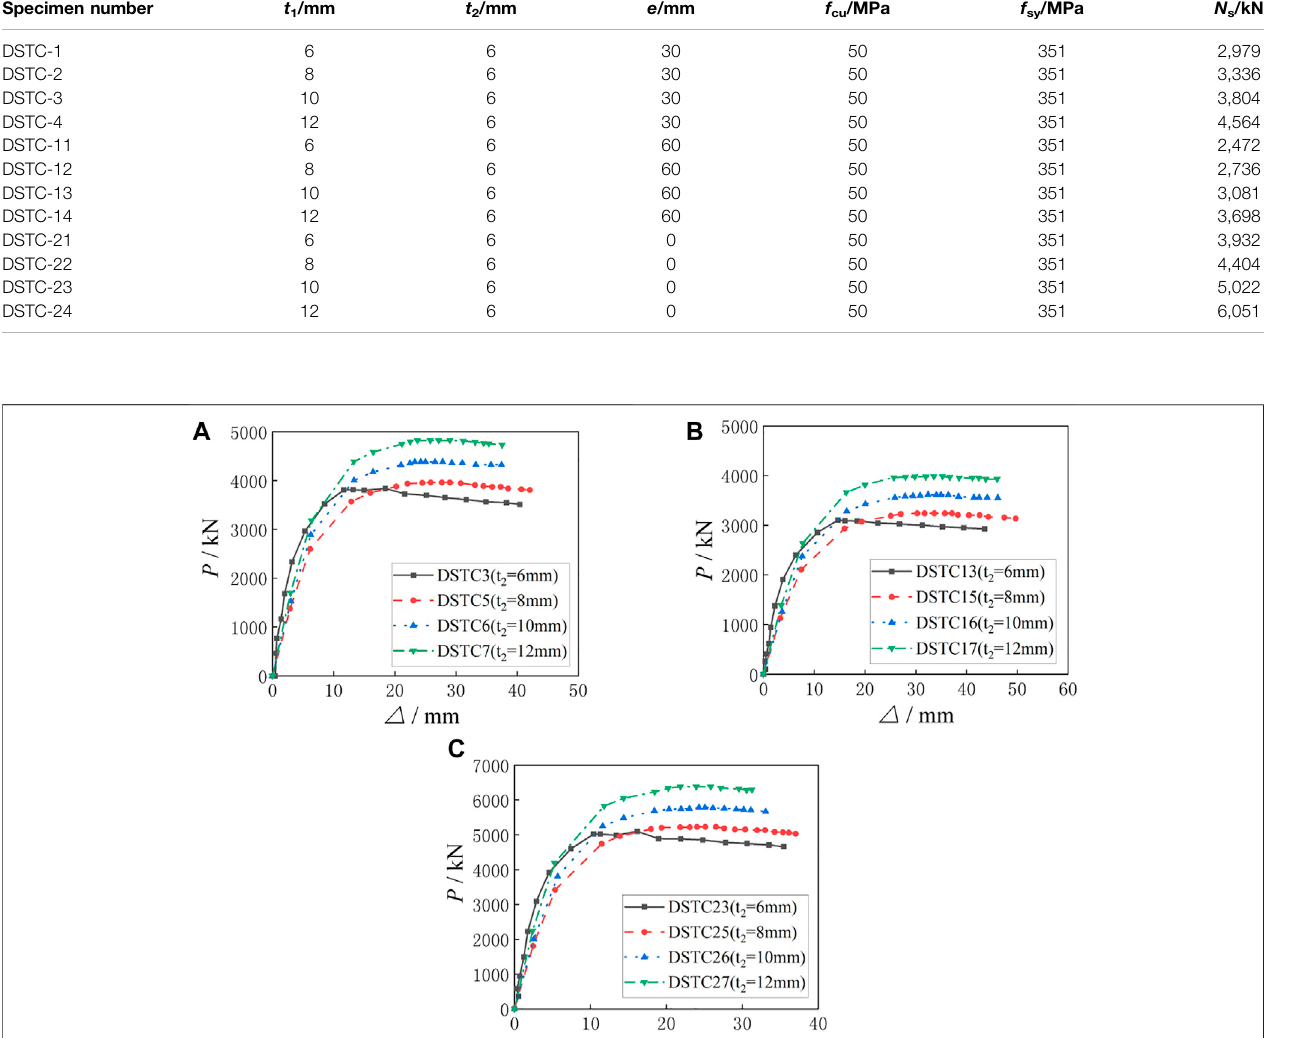
Frontiers in Materials |